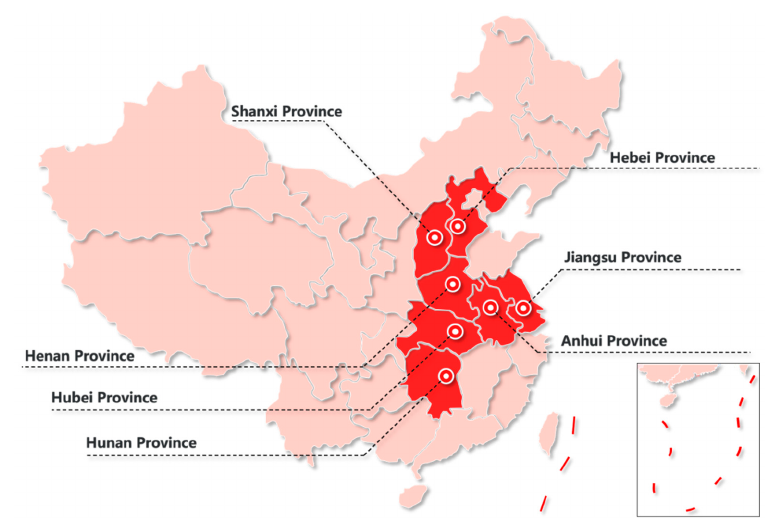
Figure 5. Investigation area distribution